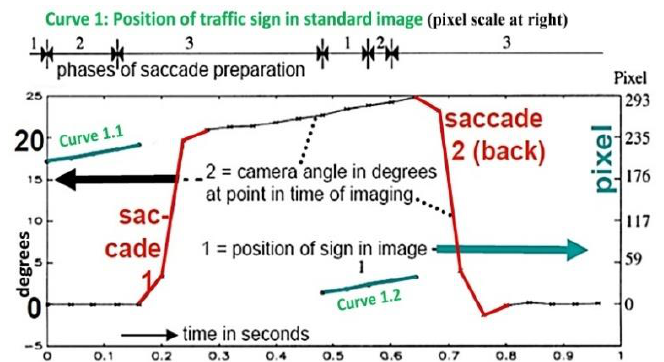
Figure 6. Detection and tracking of a traffic sign (curve 1.1); saccadic change of the gaze direction onto